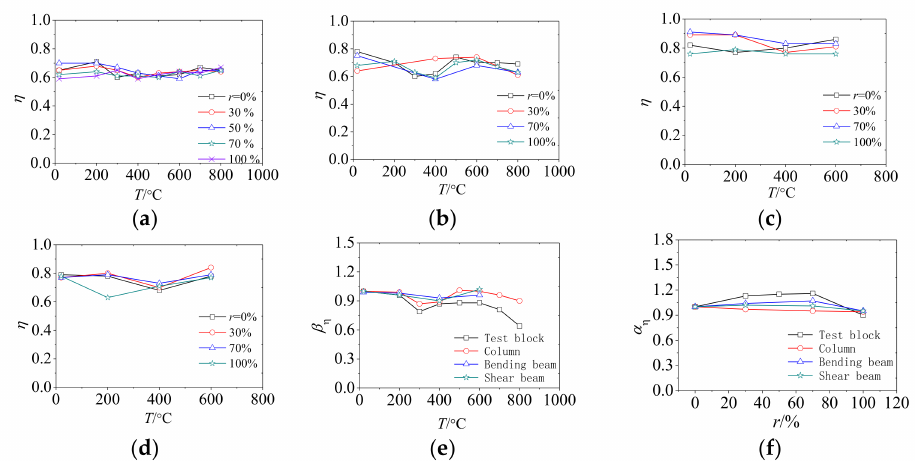
Figure 19. Energy dissipation. ( a ) rectangular prisms specimens; ( b ) columns; ( c ) bending beams; ( d ) shear beams; ( e ) The influence of temperature; ( f ) The influence of replacement